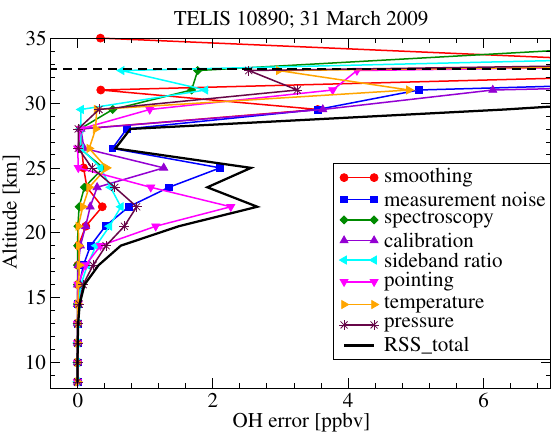
Figure 19. Individual estimates of smoothing, noise, and model parameters errors for the OH retrieval. The estimated errors correspond to TELIS FIR measurement 10890 during the 2009